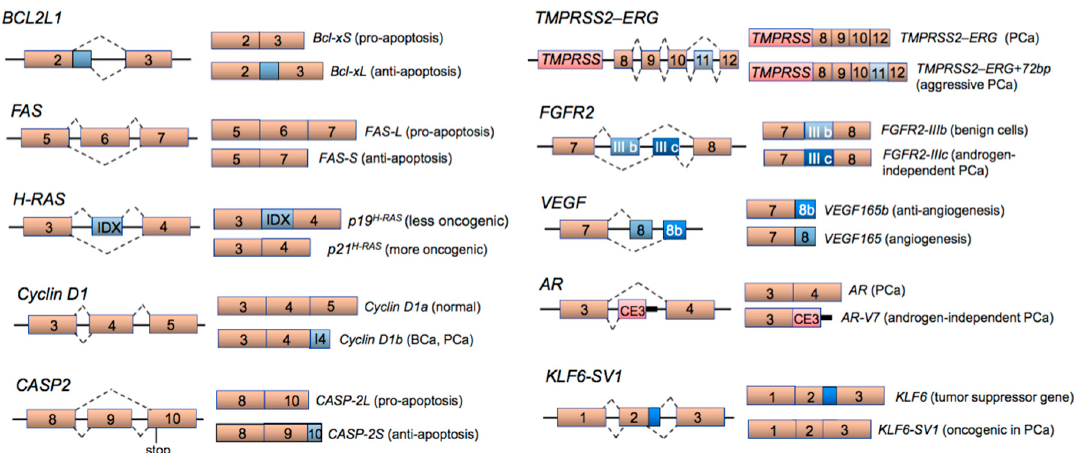
Figure 2. Alternative splicing events in cancers. Examples of aberrant splice variants and oncogenic consequences for Bcl-xL , FAS-S , p21H-RAS , Cyclin D1b , CASP-2S , TMPRSS2-ERG+72bp , FGFR2-IIIc , VEGF-165 , AR-V7 and KLF6-SV1 [20,43,47]. Abbreviations: TMPRSS2–ERG+72bp , TMPRSS2–ERG fusion transcript with inclusion of a 72-bp exon [48]; BCa, breast cancer; PCa, prostate cancer; CE3, cryptic exon 3. Overexpression of splice variant TMPRSS2–ERG+72bp has been correlated to aggressive prostate cancer with poor clinical outcome [49]. The pre-mRNAs are shown on the left panel, and the mature mRNA variants (only the exons surrounding the differential splicing event are shown) following AS are shown on the right panel.